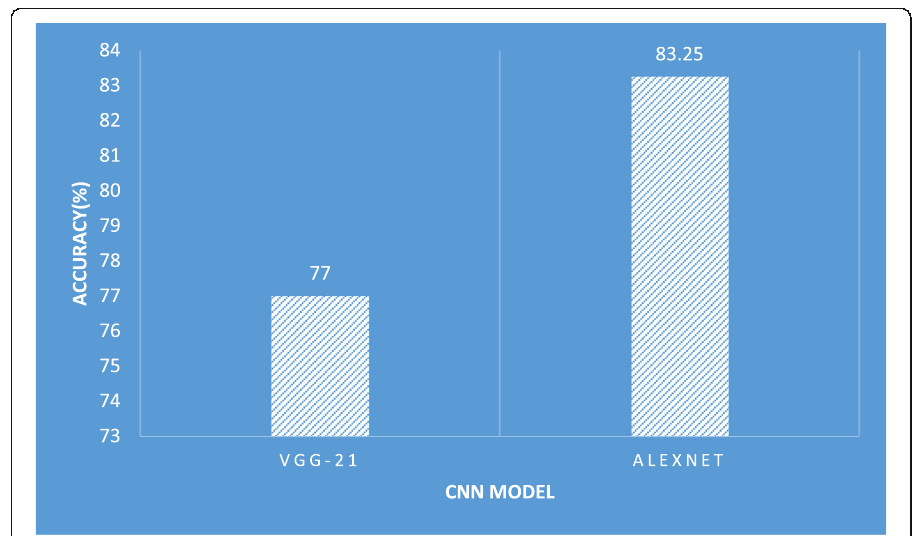
Fig. 13 Recognition rates for non-frontal facial expression recognition by using